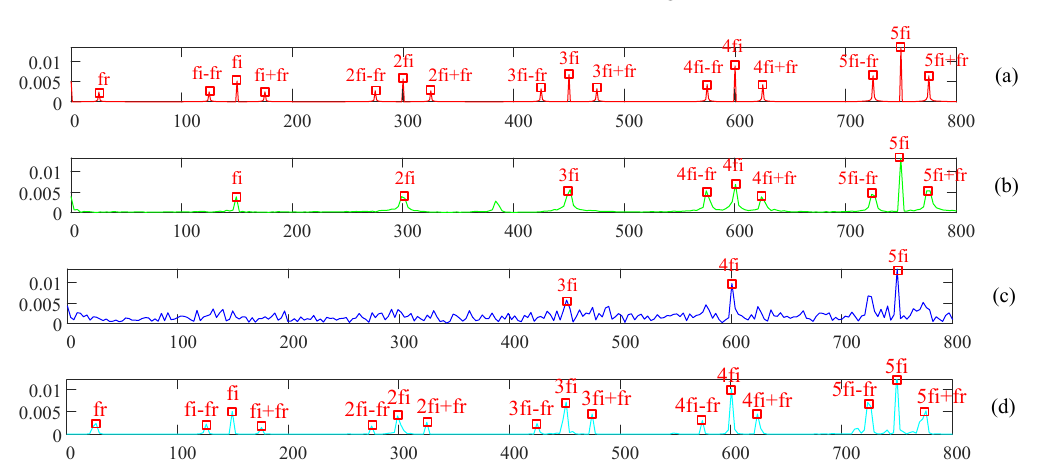
Figure 9. Comparison of various noise reduction methods. ( a ) Noise-free signal; ( b ) SVD; ( c ) EMD; ( d ) ADMD-CS.